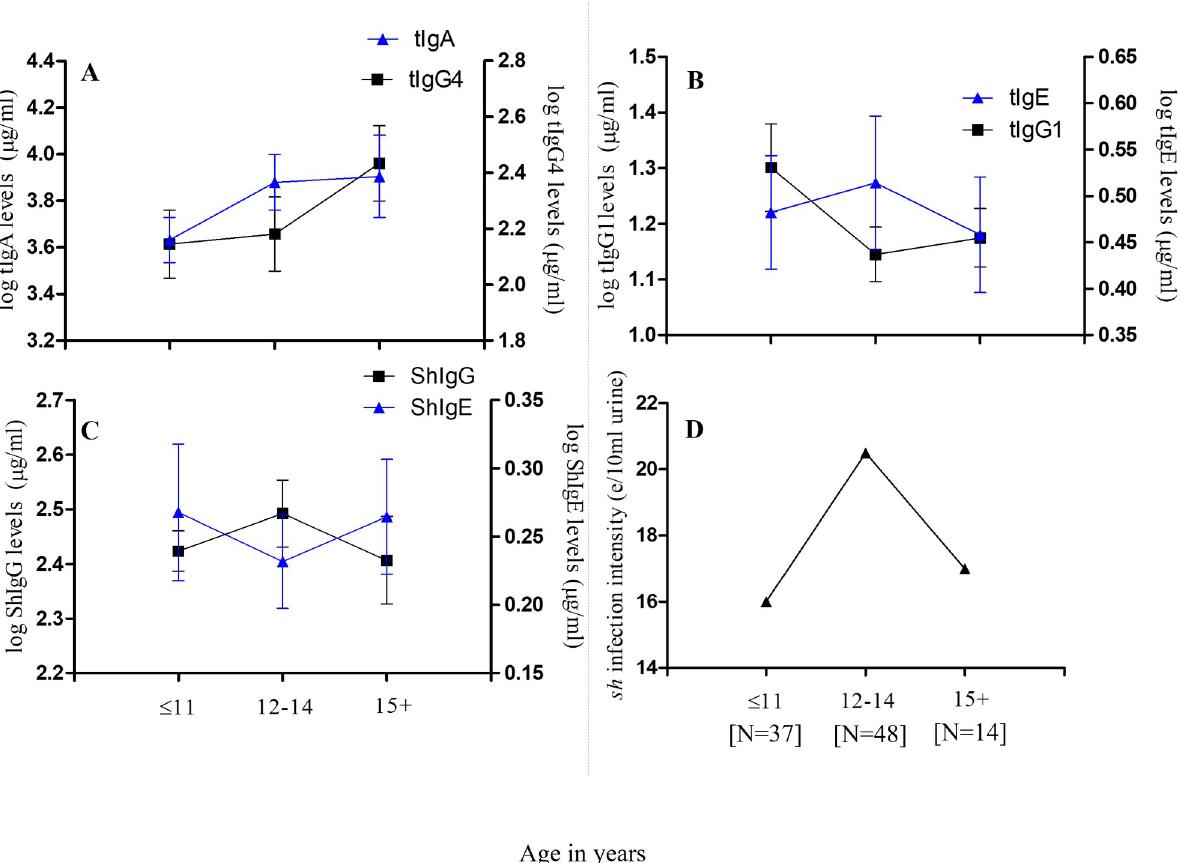
Fig 5. Stratification of measured plasma antibody levels by age among S . haematobium -infected participants (N = 99): (A) Mean total IgA (tIgA) and tIgG4 titres by age groups; (B) Mean titres of tIgE and tIgG1 by age groups. Error bars represent the standard error of mean (SEM). (C) Mean titres of S . haematobium -specific Schistosoma egg antigen (ShSEA)–IgE and ShSEA-specific IgG by age groups; and (D) GM S . haematobium infection intensity distribution by age groups among infected participants. [N] denotes the number of pupils in each age